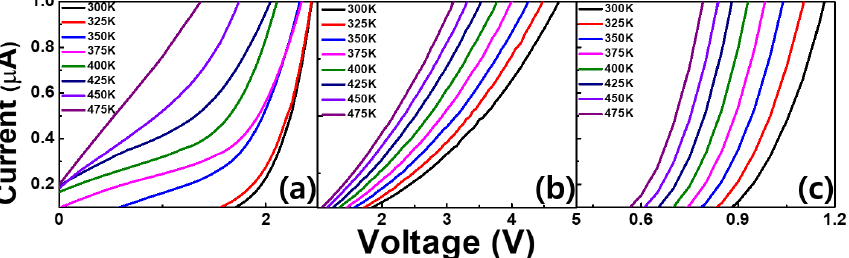
Figure 5. Forward current–voltage–temperature (I-V-T) characteristics of the fabricated AlN/4H-SiC SBD devices: ( a ) as-grown, ( b ) N 2 -annealed, ( c ) O 2 -annealed.